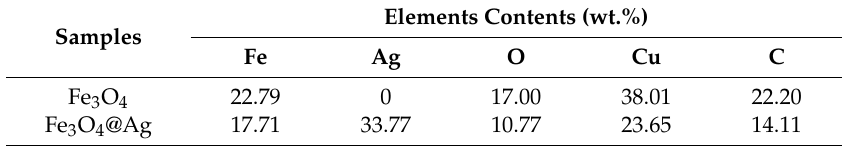
Figure 3. TEM and energy dispersive X-ray spectrometry (EDS) images of ( a ) Fe 3 O 4 particles and ( b ) Fe 3 O 4 @Ag particles deposited on carbon-coated Cu grids. Table 1. Elements contents of Fe 3 O 4 nanoparticles and Fe 3 O 4 @Ag nanoparticles in the red areas.